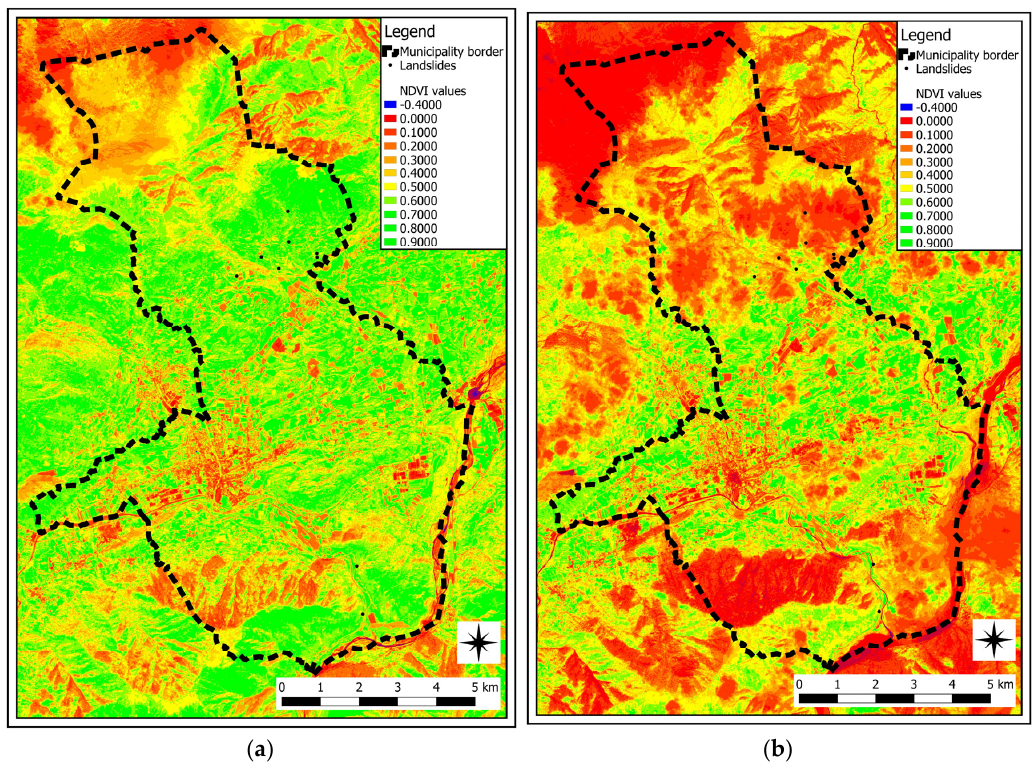
Figure 17. NDVI of the area before and after the event. Images from the satellite Sentinel-2B, acquisitions of 11 October 2018 ( a ) and 31 October 2018 ( b ).